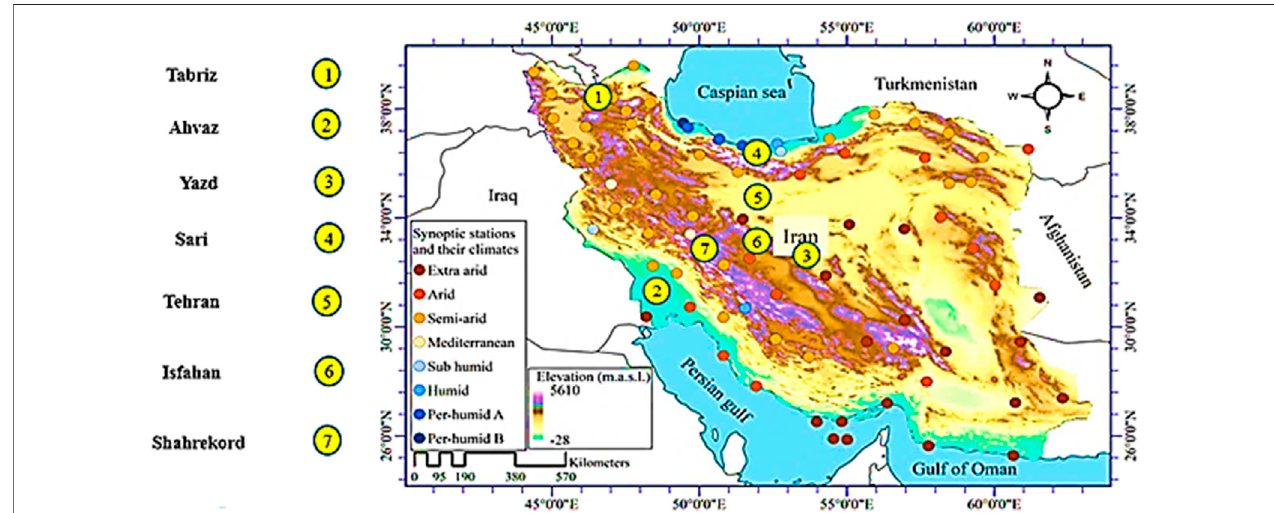
FIGURE 1 | The location of synoptic